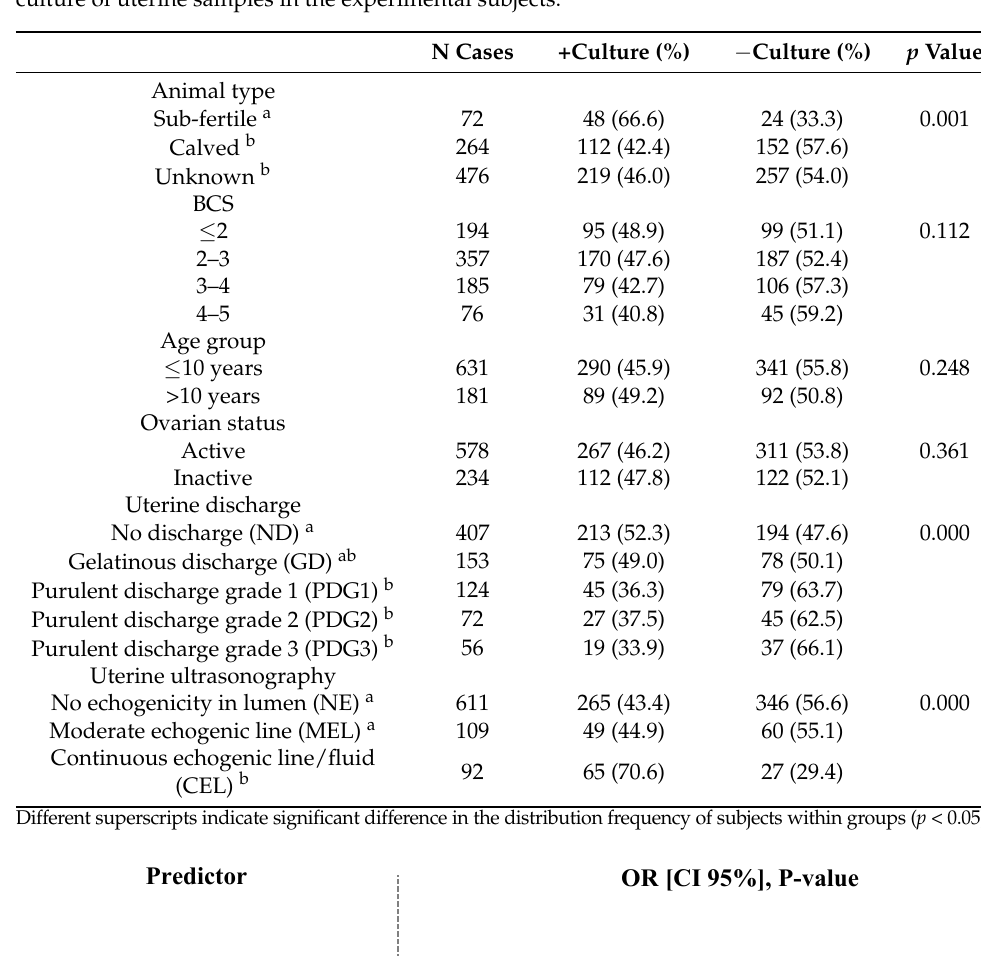
Table 3. Data composition of clinical features and frequency distribution of negative and positive culture of uterine samples in the experimental subjects.